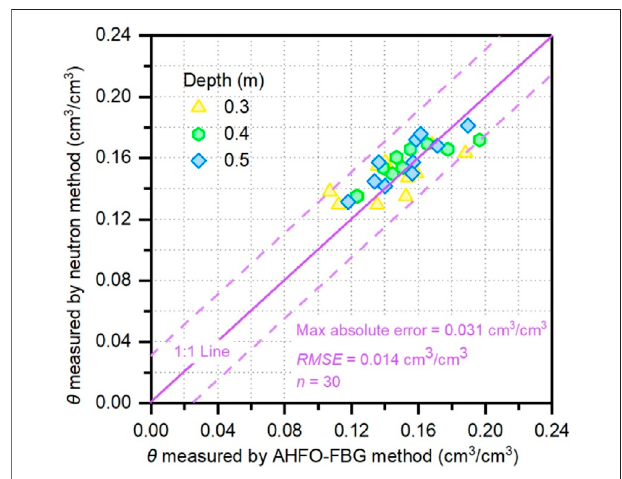
FIGURE 8 | Comparison results of soil water content measured by APHS and neutron probe on January 6, 2020 (Sun et al., 2021).